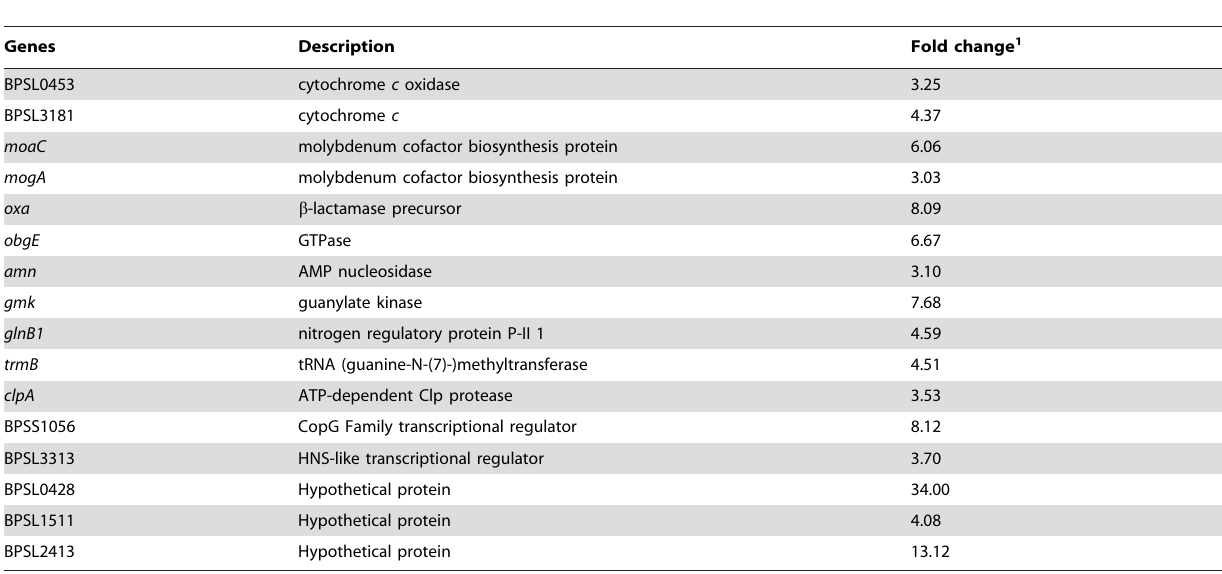
Table 1. Positively selected genes bearing transposon mutations that increase the tolerance of B. pseudomallei to imipemen.